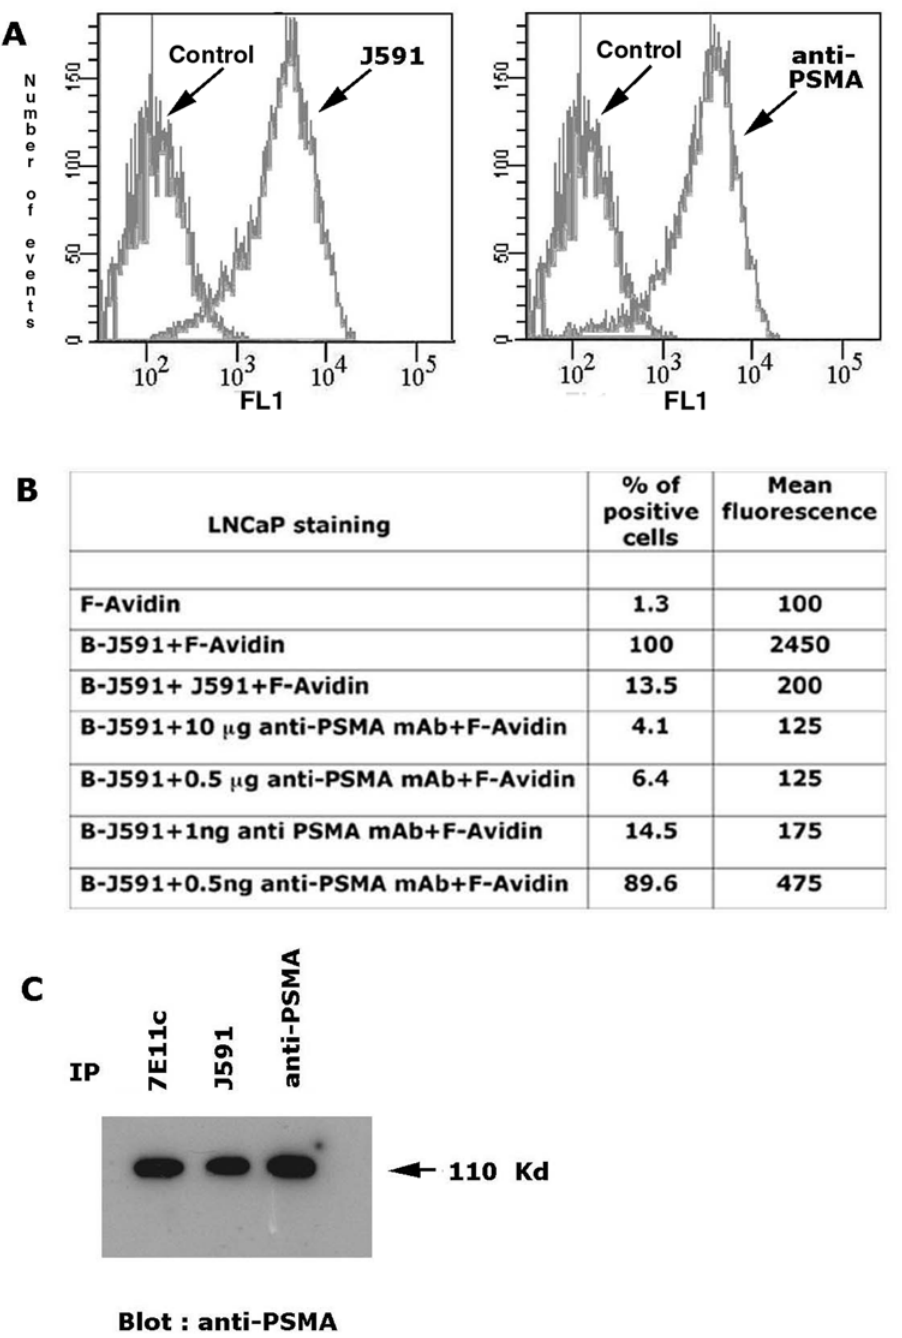
Figure 1. Reactivity of anti-PSMA mAb. Panel A: representative flow cytometry of LNCaP cells stained with anti-PSMA or with J591 mAb. Controls are represented by cells goat anti-mouse-FITC IgG only. Panel B: flow cytometry of LNCaP cells incubated with biotinylated J591 mAb (B-J591) with or without pretreatment (45 min on ice) with anti-PSMA at the indicated concentrations or with non-biotinylated J591 mAb as control. Antibody binding was revealed by FITC-Avidin (F-Avidin). The percentage of positive cells and the Mean Fluorescence Intensity observed under the different conditions are representative of two independent experiments performed with independent cultures. Panel C: Western blot analysis of LNCaP cell lysates immuneprecipitated with the indicated mAbs, and then probed with the anti-PSMA mAb followed by a goat anti-mouse antiserum labelled with horseradish peroxidase. The apparent molecular weight of PSMA band is indicated by the arrow. doi:10.1371/journal.pone.0004608.g001 antibodies specifically detecting the active, phosphorylated form 7E11c or with Gam alone and the use of untreated cells. Cells of the two kinases. As shown in Fig. 2A and B, ERK1/2 and p38 were then washed and used as a source of cell lysates. We first were found activated at low levels in untreated LNCaP cells. Upon assayed the phosphorylation of p38 and ERK1/2 in crude lysates PSMA cross-linking, both ERK1/2 and p38 became considerably obtained from the same cell cultures immunoblotted with